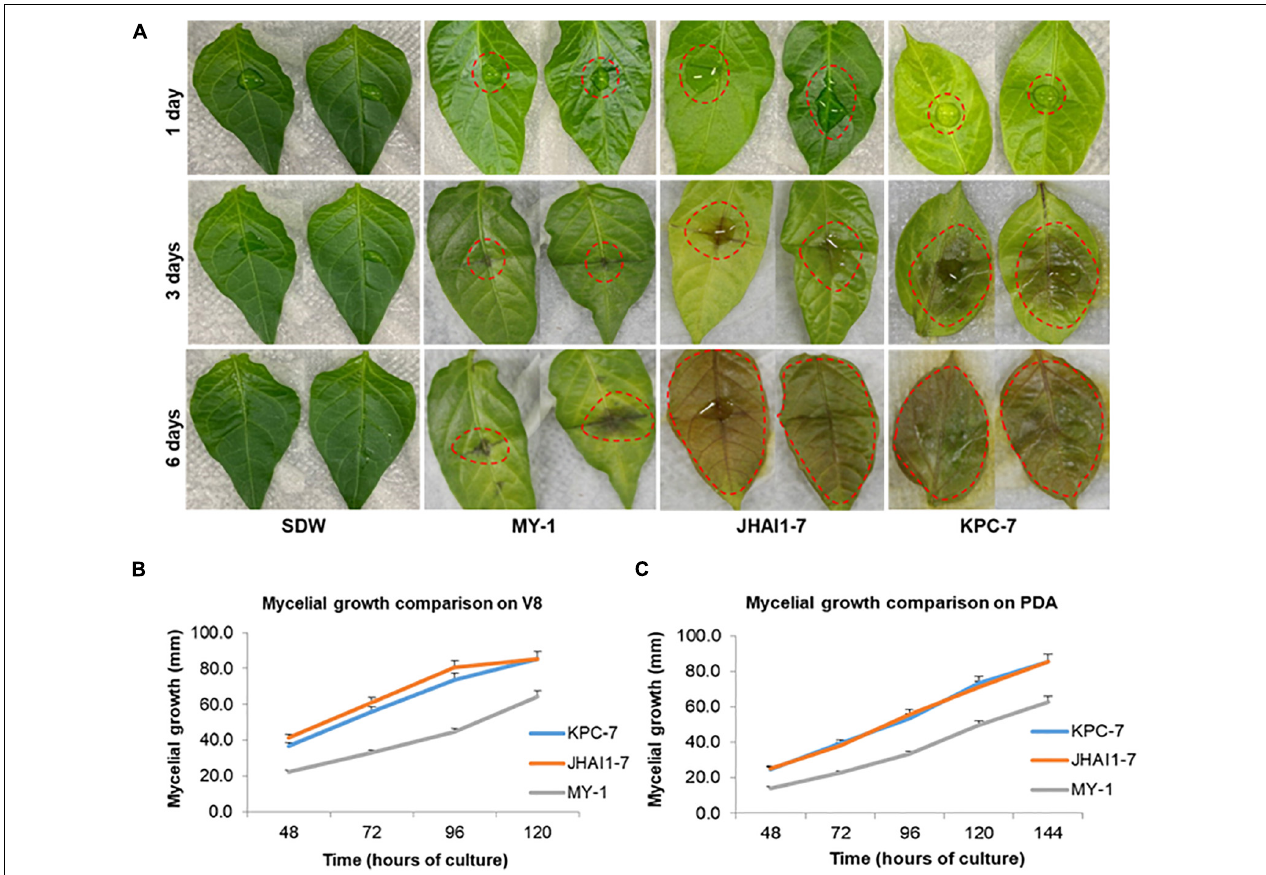
FIGURE 1 | Detached leaf assay and mycelium growth comparison for aggressiveness assessment. (A) Detached leaf assay. Sterile distilled water (SDW) was used as a mock control. The red dotted lines indicate the P. capsici -infected lesion area. (B) Mycelial growth on V-8 agar medium. (C) Mycelial growth on potato dextrose agar (PDA) medium. The bars indicate the standard error of means n =